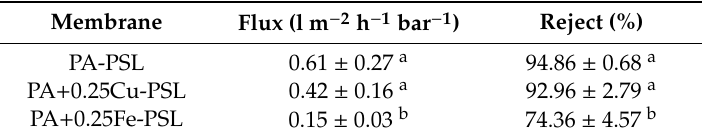
Table 2. Desalination performance of